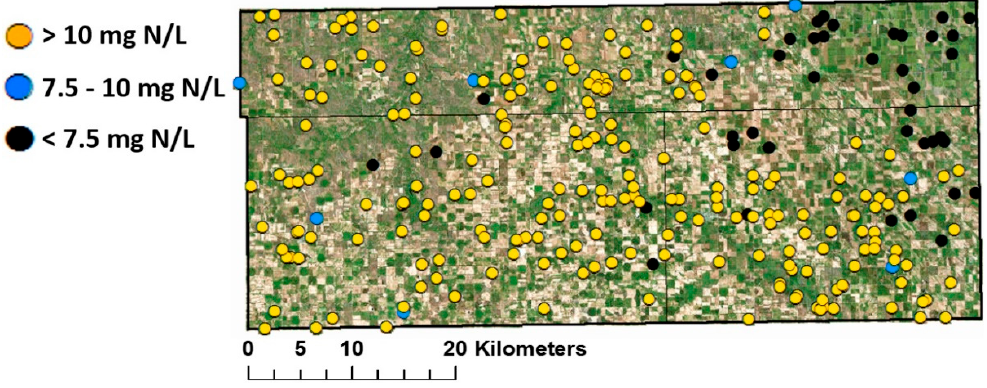
Figure 6. Wells predicted to surpass the 7.5 and 10 mg NO 3 -N/L thresholds under intensive cropping systems from 2009 to 2015 in the Bazile Groundwater Management Area. Only predicted wells are shown; other wells with nitrate data were used as inputs to develop the model.